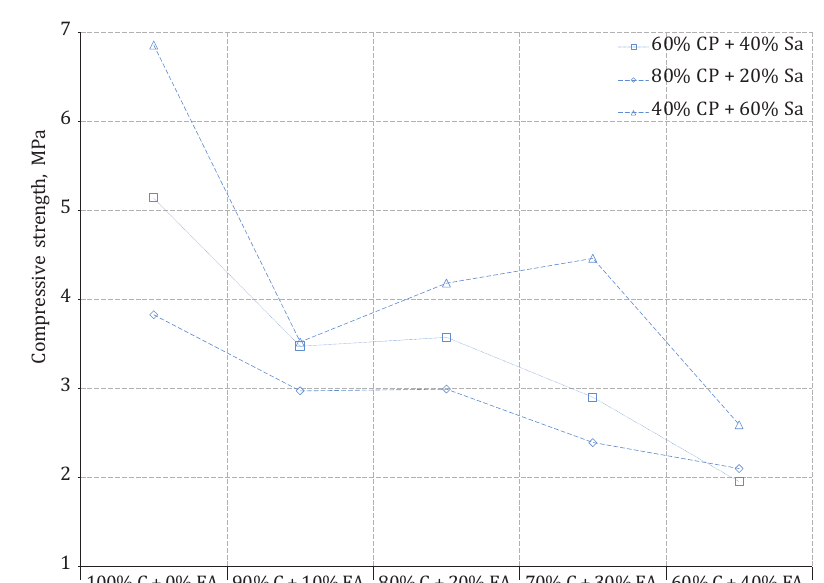
Figure 6. Fly ash effect on strength after 183 days (Zakarka et al., 2019)